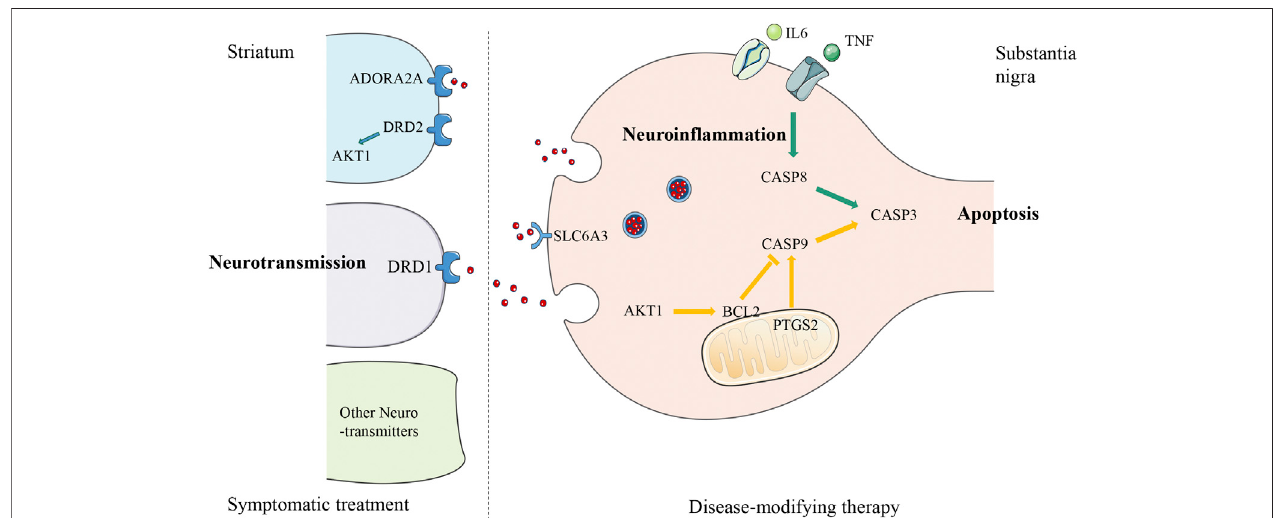
FIGURE 4 | Schematic diagram of the underlying mechanism of Paeonia lacti fl ora P. in Parkinson ’ s disease. The diagram of a nigro-striatal synapse shows three possible approaches that can be used as therapeutic targets. Parkinson ’ s disease is caused by the early death of dopaminergic neurons in midbrain substantia nigra leading to the reduction of dopamine neurotransmitters released to the striatum, so treatment could be either targeting the degeneration process as disease-modifying therapy (presynaptic, right side of the diagram), or synaptic transmission as symptomatic treatment (postsynaptic, left side of the diagram). The putative targets of Paeonia lacti fl ora P. are located on three pathways: the green arrows from TNF, IL-6, to CASP8, CASP3 are part of the extrinsic apoptosis pathway induced by neuroin fl ammation, the yellow arrows from CASP9 to CASP3 with the involvement of AKT1, BCL2, and PTGS2, belong to the intrinsic apoptosis pathway, and blue receptors DRD1, DRD2, ADORA2A, SLC6A3 and AKT1 are related tothe regulation ofneurotransmitters level. TNF, Tumor Necrosis Factor; IL-6, Interleukin 6; CASP8, Caspase-8; CASP9, Caspase-9; CASP3, Caspase-3; PTGS2, cyclooxygenase 2 (COX2); BCL2, Apoptosis regulator Bcl-2; AKT1, RAC-alpha serine/threonine-protein kinase (PKB);ADORA2A,Adenosine receptor A2a; DRD1,DopamineD1 receptor; DRD2,DopamineD2 receptor; SLC6A3, Sodium-dependent dopamine transporter.